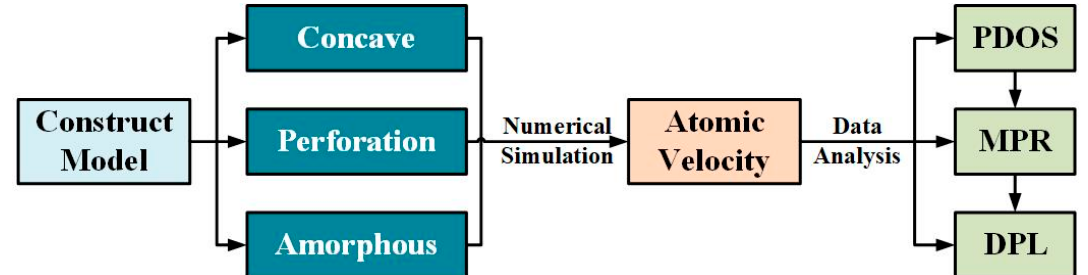
Figure 4. Calculation flow chart.